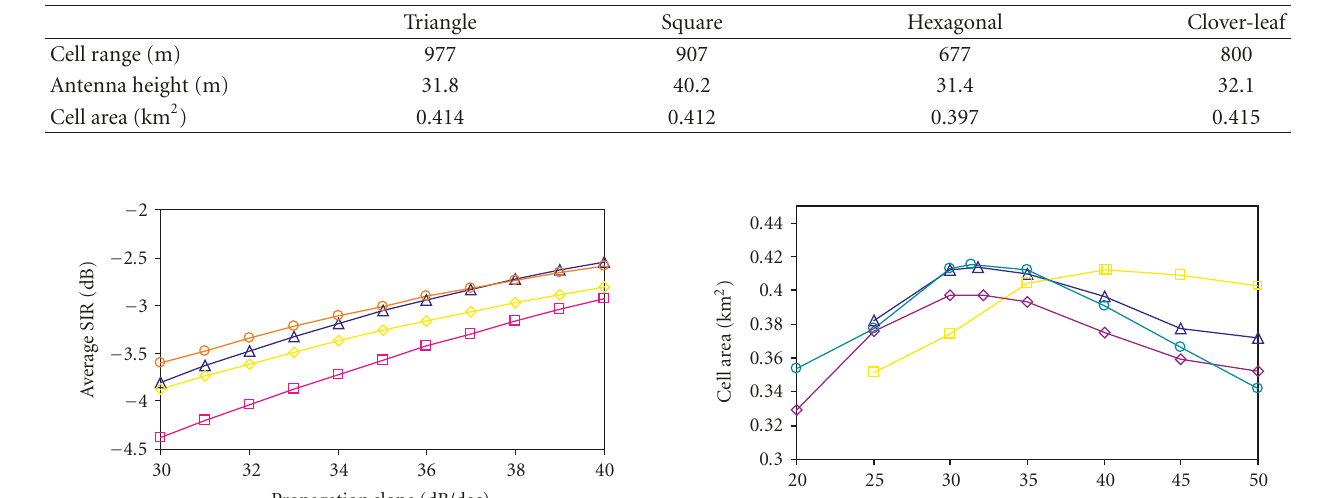
Table 4: System simulation results.